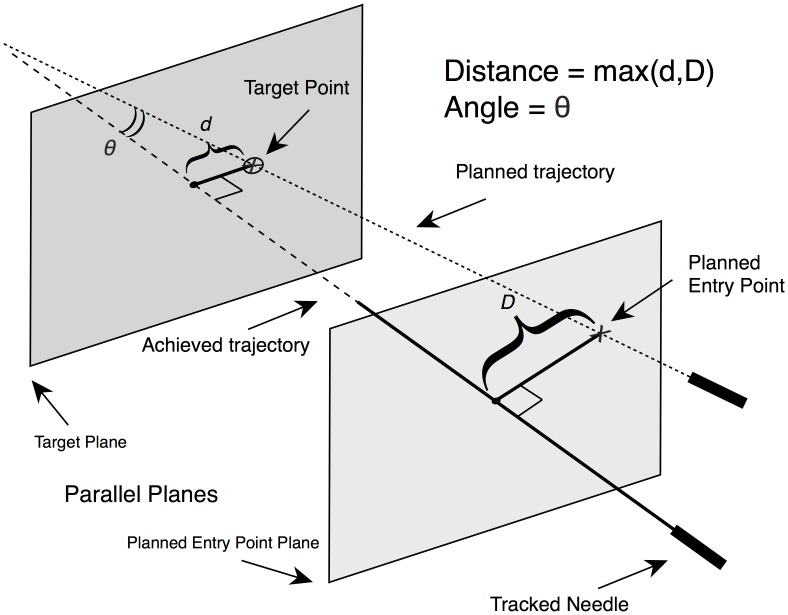
Main outcome computation.The accuracy of the initial needle placement is computed as the maximum distance between the planned trajectory and the achieved trajectory of the needle: Distance error = max(d,D), with d = distance between the achieved trajectory and the Planned Target Point, D = distance between the achieved trajectory and the Planned Entry Point. The achieved trajectory is defined as the straight line which passes through the actual position of the needle extracted from the first control CT acquisition, i.e. the straight line passing through the needle skin entry point and the needle tip (cf. Fig 3). This maximum distance error is computed along the entire real needle path, as if no iterative needle trajectory adjustments were made after the initial needle placement and as if the needle was pushed straight ahead up to the target depth. Thus it is related to the initial risk that neighboring critical tissue would be punctured by the needle, or that the target would not be reached by the needle tip. The angle θ between the planned trajectory and the needle is also computed.